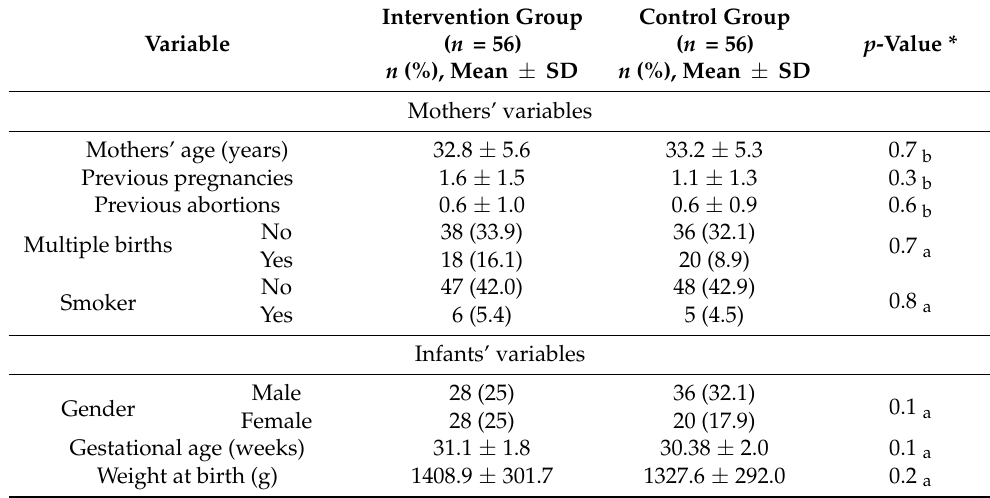
Table 1. Maternal and infant demographic and clinical data of the intervention group and the control group.